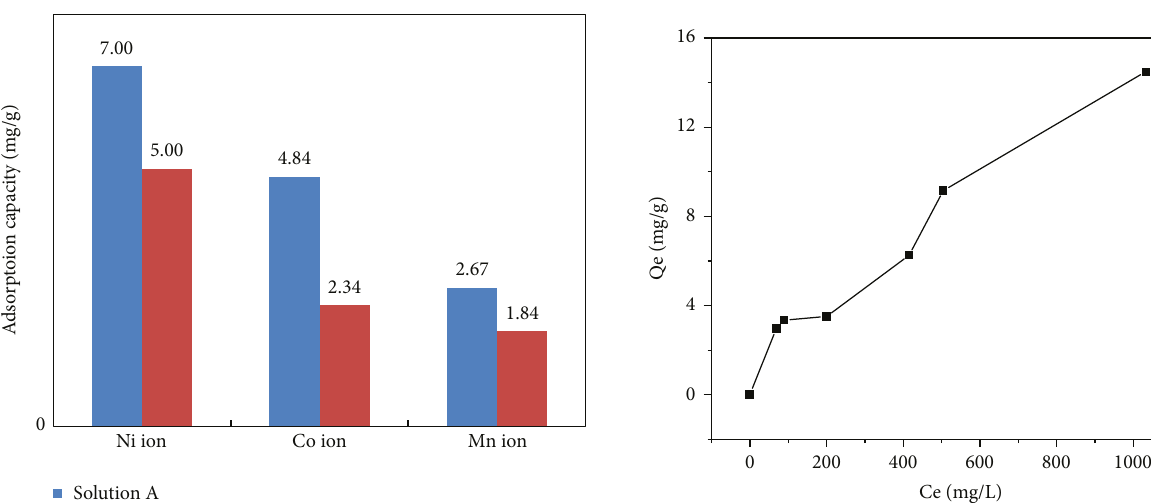
Figure 9: Absorption capacity of concentration of different initial Ni, Co, and Mn ions by DPRC-600 °